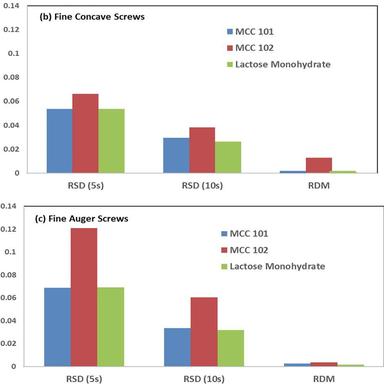
Feeding RSD (5 and 10 s moving average) and RDM of MCC PH101, MCC PH102 and Lactose Monohydrate with (a) Coarse Concave Screws, (b) Fine Concave Screws, (c) Fine Auger Screws. All runs were at 70% Drive Command. RSD: relative Standard Deviation. RDM: relative deviation from the Mean.